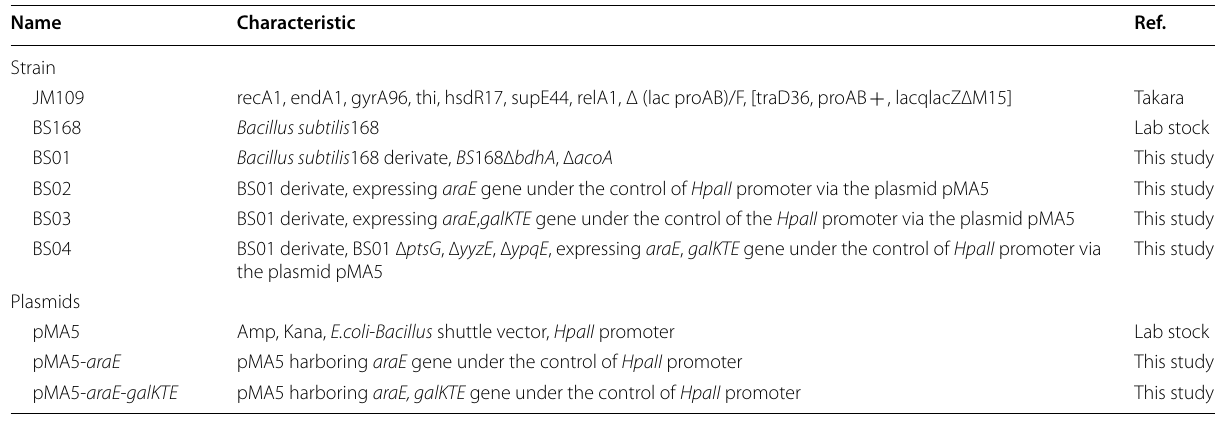
Table 1 Strain and plasmid used in